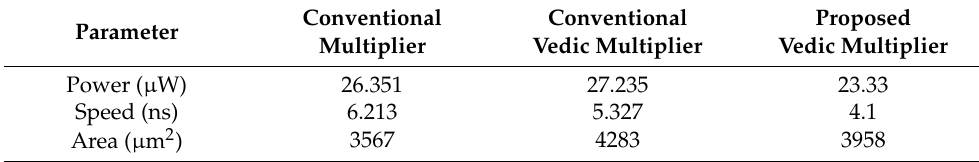
Table 2. Resource utilization of 32 × 32 multiplier. Parameter Slice LUT DSP IOB Xilinx IP 415 93 Ours